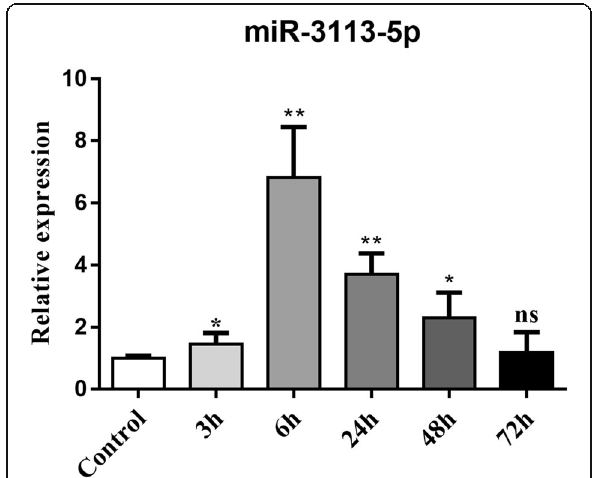
Fig. 6 Circulating microRNA 3113-5p significantly increased in the early perfusion hours in human serum samples. Serum samples from healthy people who underwent routine health checkup served as control (Ctrl). Three patients with myocardial infraction and underwent stent implantation were collected sera during time periods of 3 h,6 h, 24 h, 48 h and 72 h. *, P < 0.05, ***, P < 0.0001 vs.